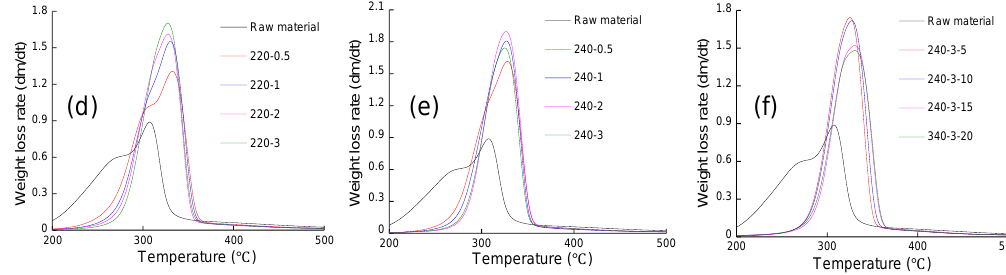
Figure 3. TG (thermogravimetry) ( a – c ) and DTG (differential TG) ( d – f ) profiles of raw material and glycerol pretreated corncobs.